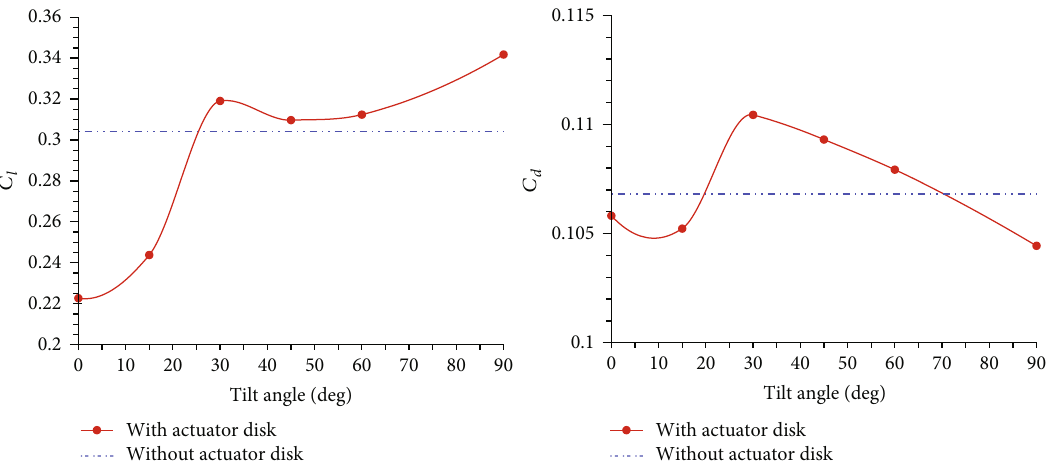
Figure 24: Quasi-steady lift and drag coe ffi cients at fi xed tilt angles.